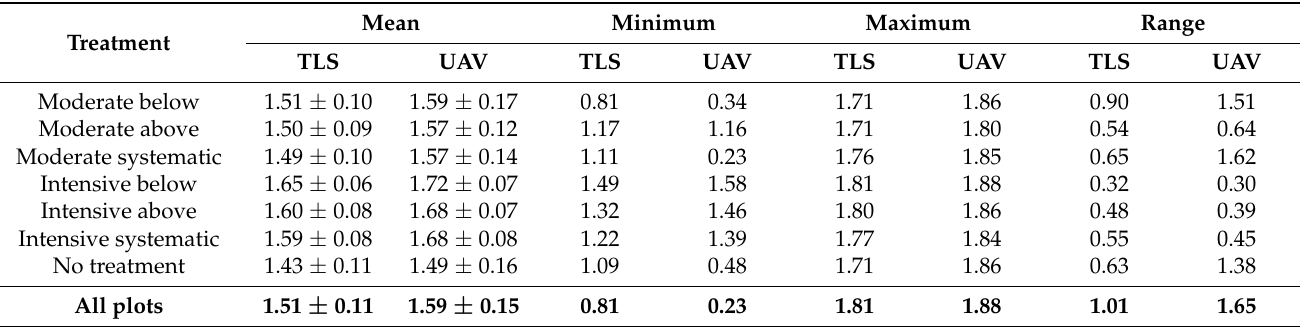
Table 6. Means (with standard deviations, ± ), minimums, maximums, and ranges of terrestrial laser scanning (TLS) and unmanned aerial vehicle (UAV) measured box dimension (D b ) values within different thinning